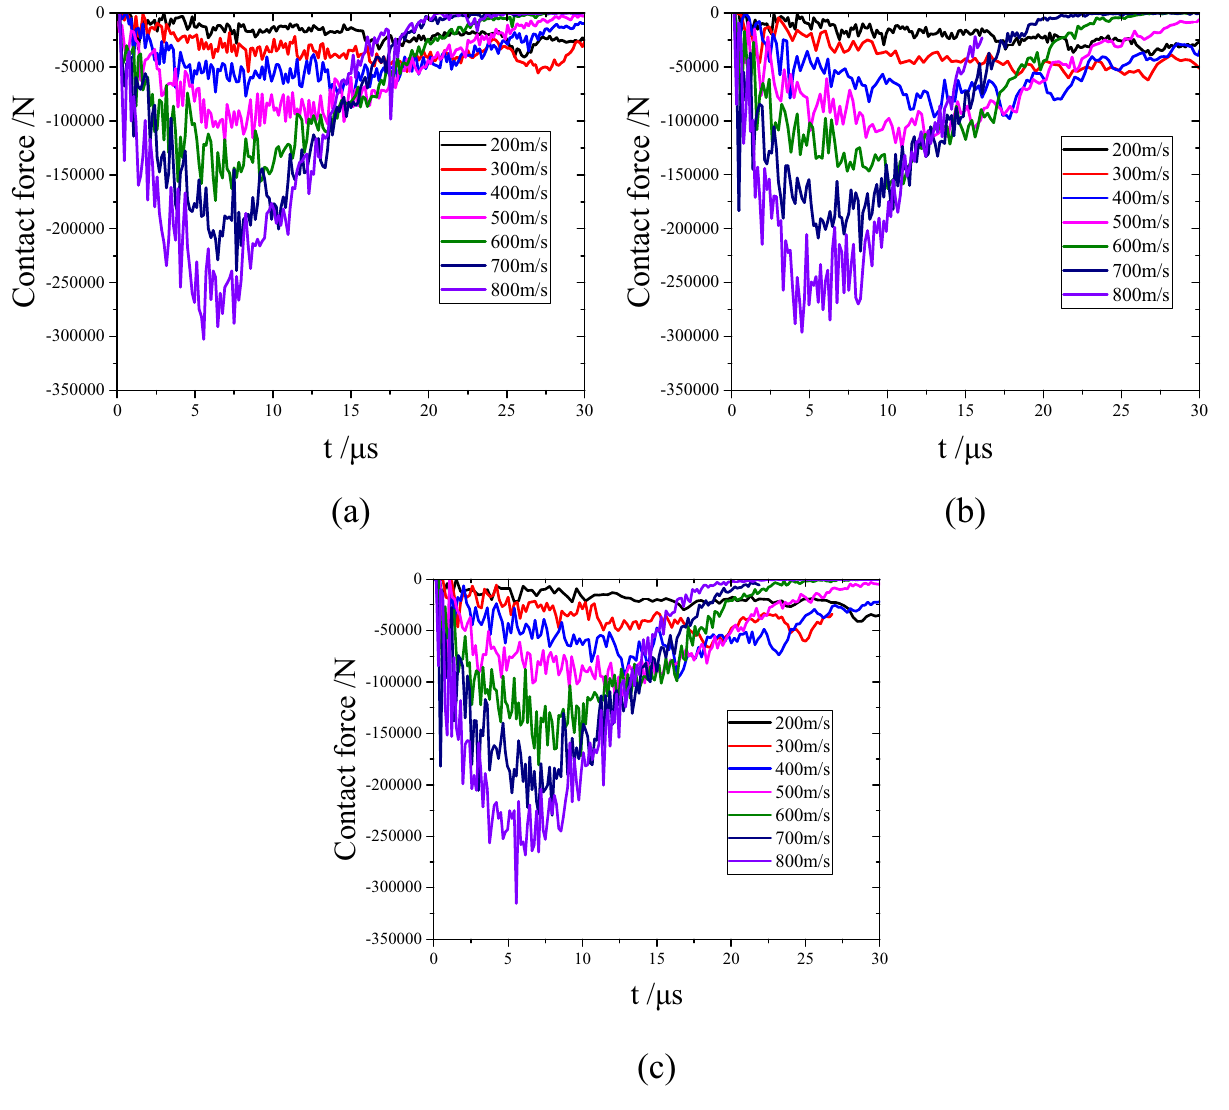
Figure 6: Contact forces of simulation: ( a ) carbon, ( b ) Kevlar, and ( c )